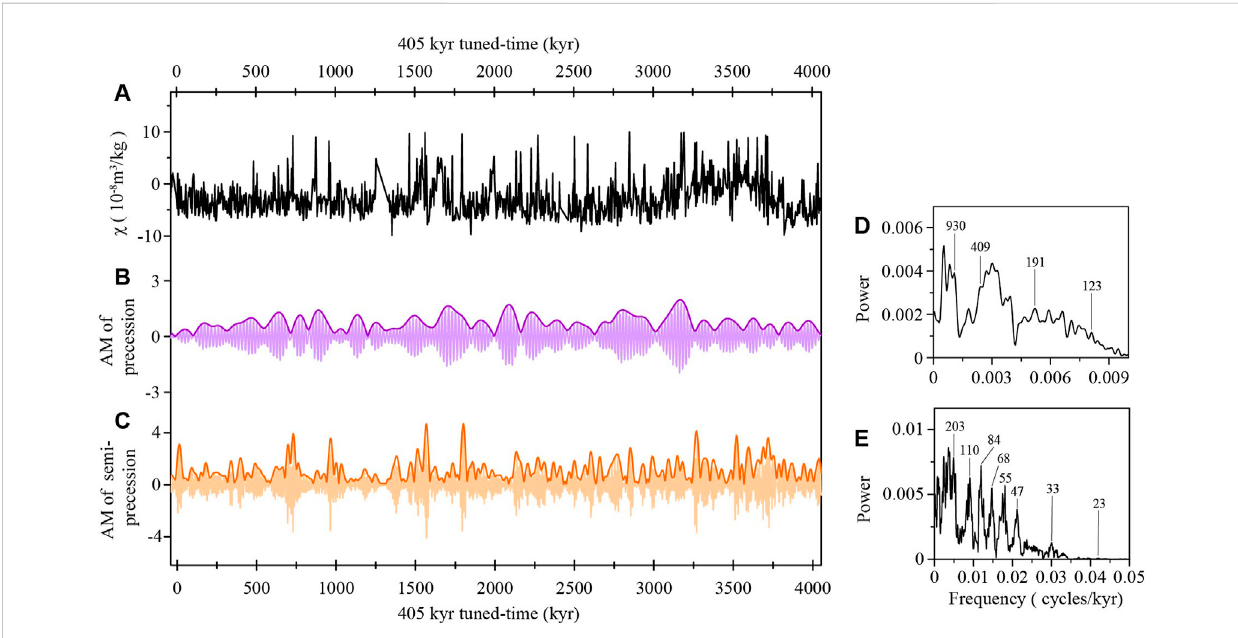
FIGURE 10 Amplitude modulations of the (C) semi-precession and (B) precession signals from the 405-kyr tuned χ series (A) , and the corresponding 2 π MTM spectra of the individual amplitude modulation curve (D, E)